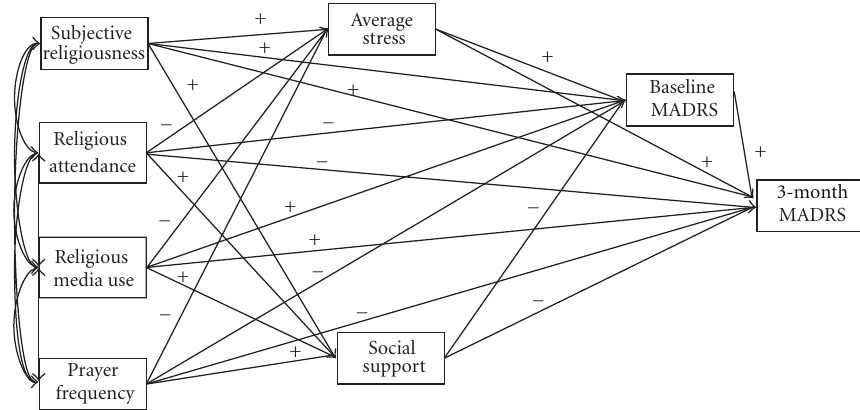
Figure 1: Theoretical path model for e ff ects of religious factors on depression severity. MADRS: Montgomery- ˚Asberg Depression Rating